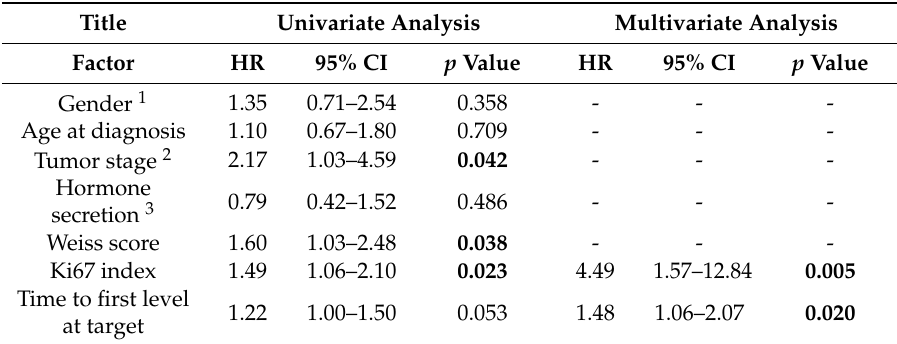
Table 3. Univariate and multivariate analysis of predictive factors for recurrence-free survival (RFS). HR = Hazard Ratio. The bold indicates the statistically significant